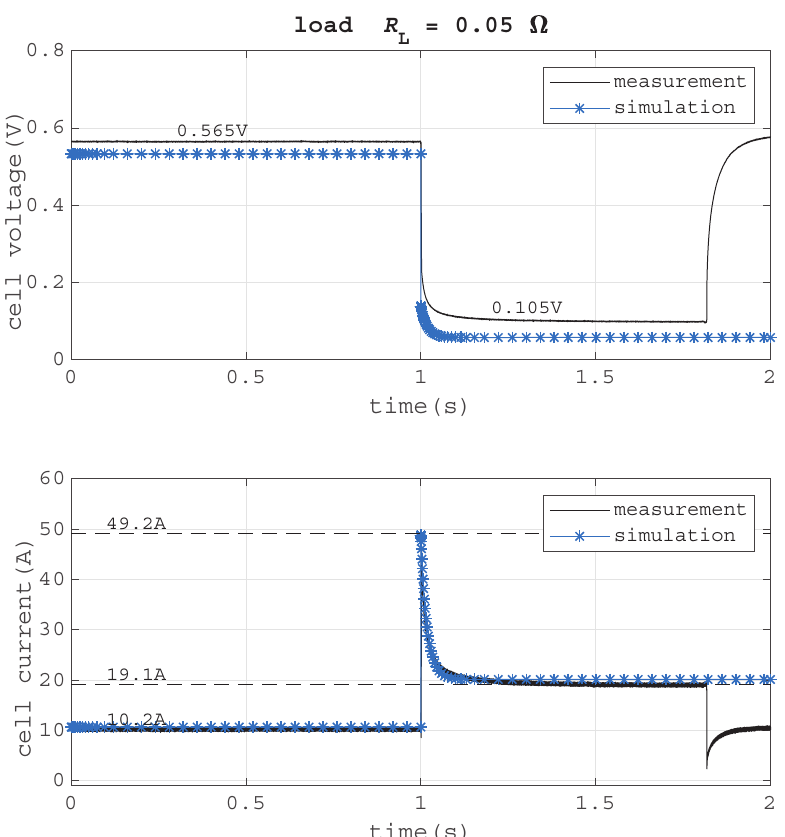
Figure 14. Comparison of measured and simulated fuel cell behavior at R load = 0.05 Ω : ( top ) transient voltage, ( bottom ) transient